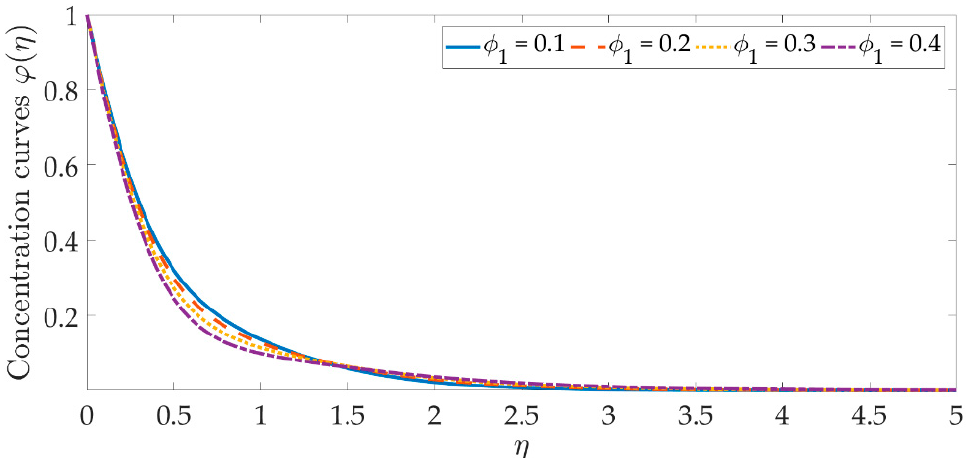
f Figure 14. Concentration curves against the multiple values of φ 1 .